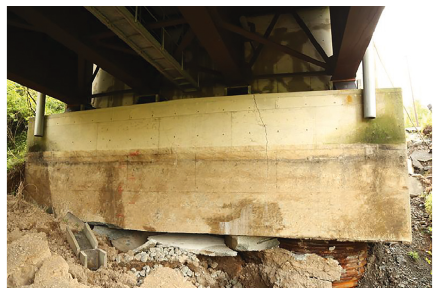
Figure 15: Damage to abutment A1 (interior).